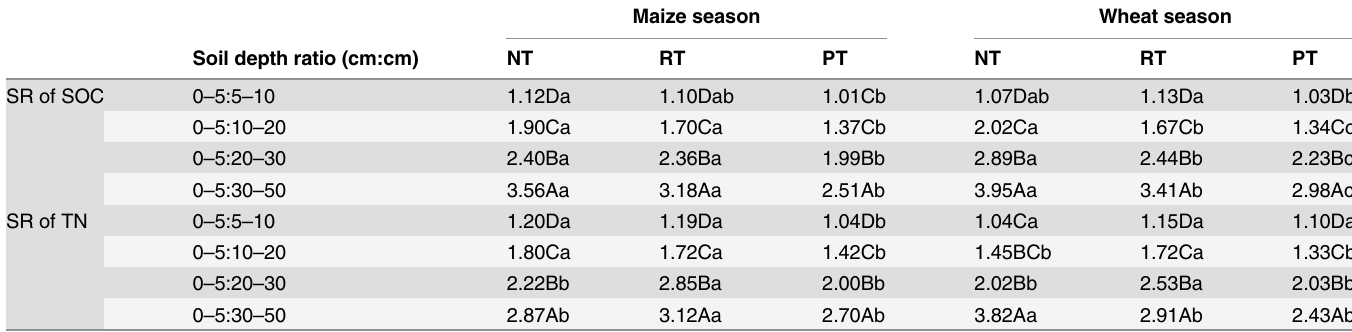
Table 3. Stratification ratio (SR) of the soil organic carbon (SOC) and the total nitrogen (TN) for the wheat and maize